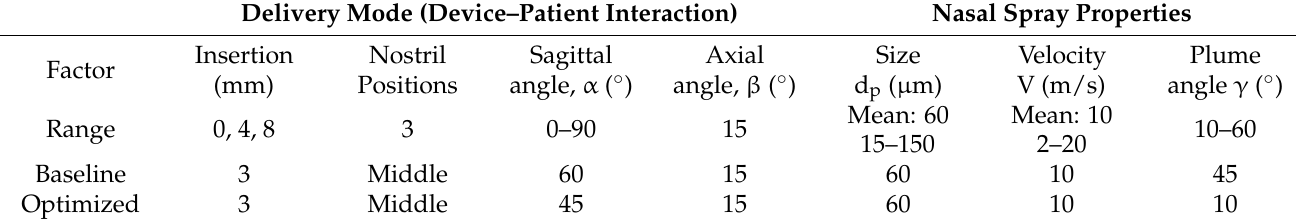
Table 1. Nasal spray delivery factors.